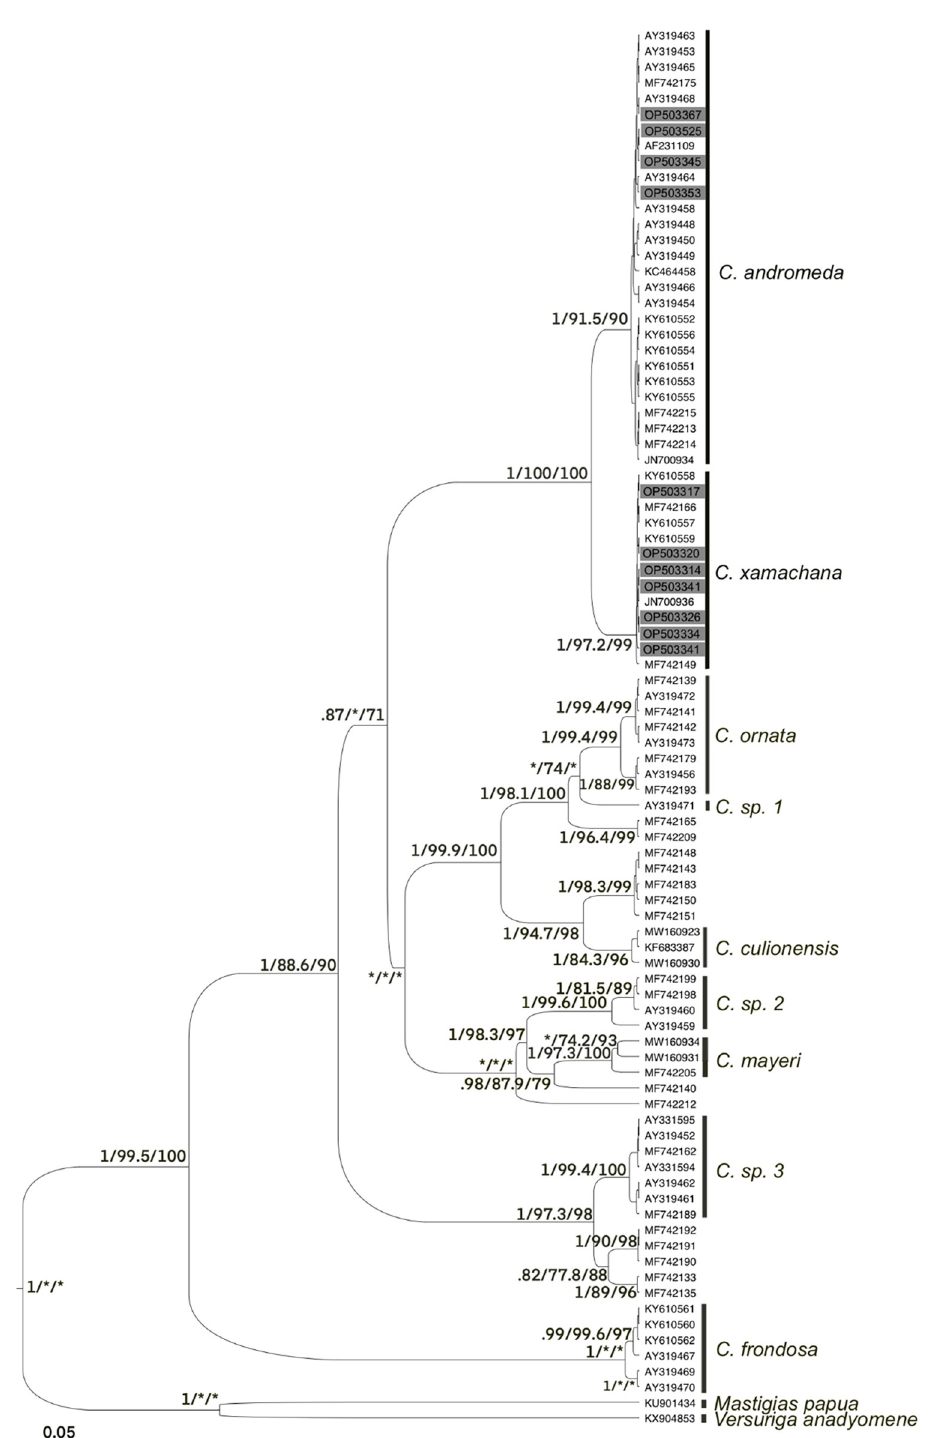
Fig 1. Combined COI and 16S tree of Cassiopea . Maximum likelihood COI + 16S tree with posterior probability, aLRT, and bootstrap supports. Individuals in grey were sequenced in this study. All accession numbers are for COI , see 16S accession numbers in Table 1. Asterisk ( * ) represents under .70 (PP) or 70 (aLRT and bootstrap) support. Species names are assigned in accordance with Gamero-Mora et al. 2022.